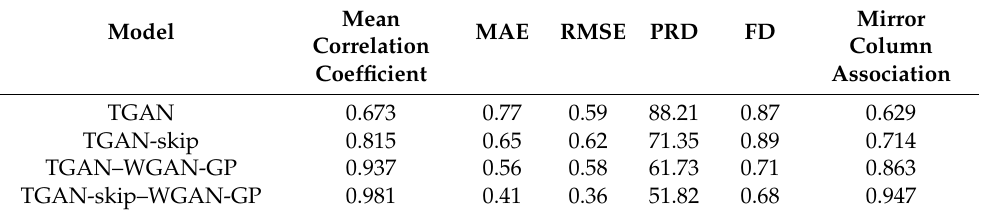
Table 3. Performance comparison of various GAN models with our proposed TGAN-skip–WGAN- GP